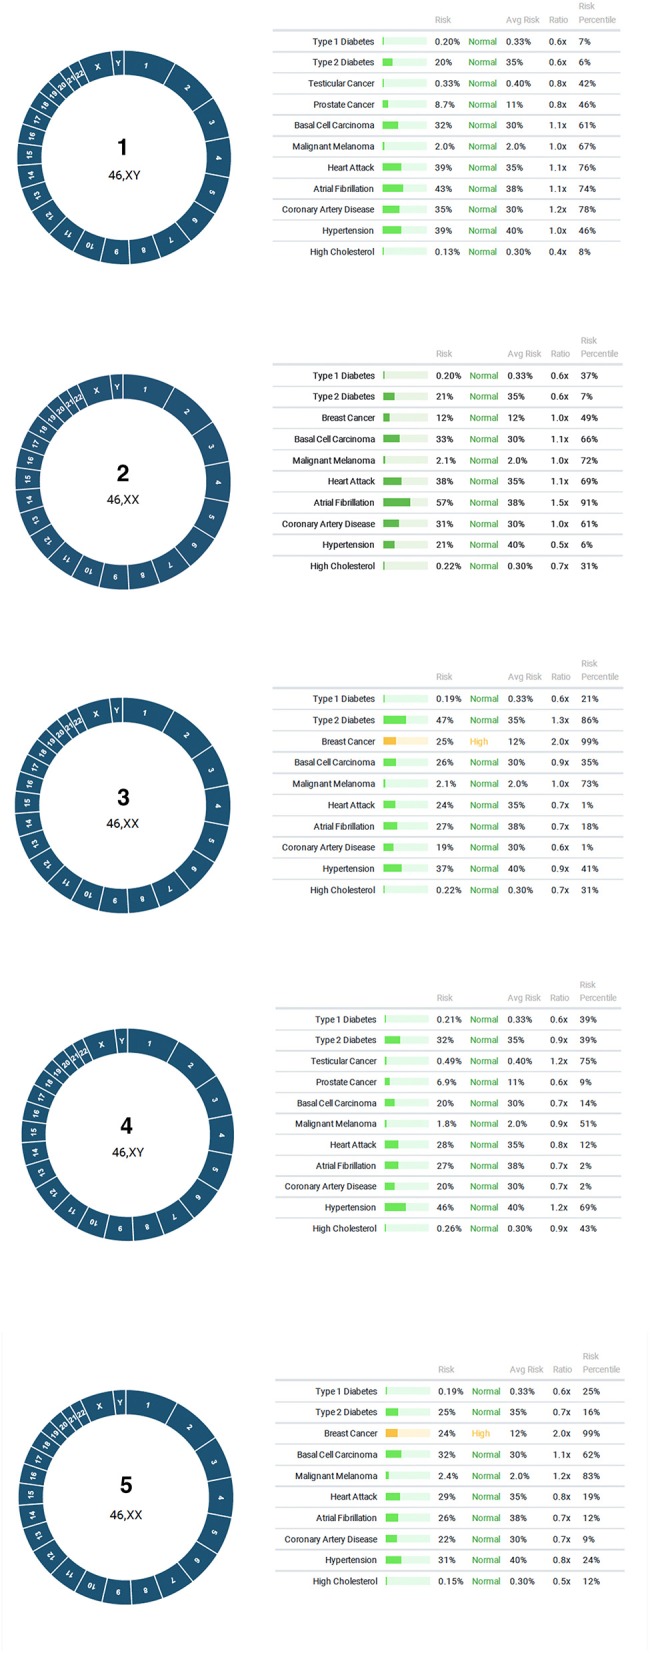
Results of PGT-P. All five embryos were euploid, with two displaying high risk for breast cancer.